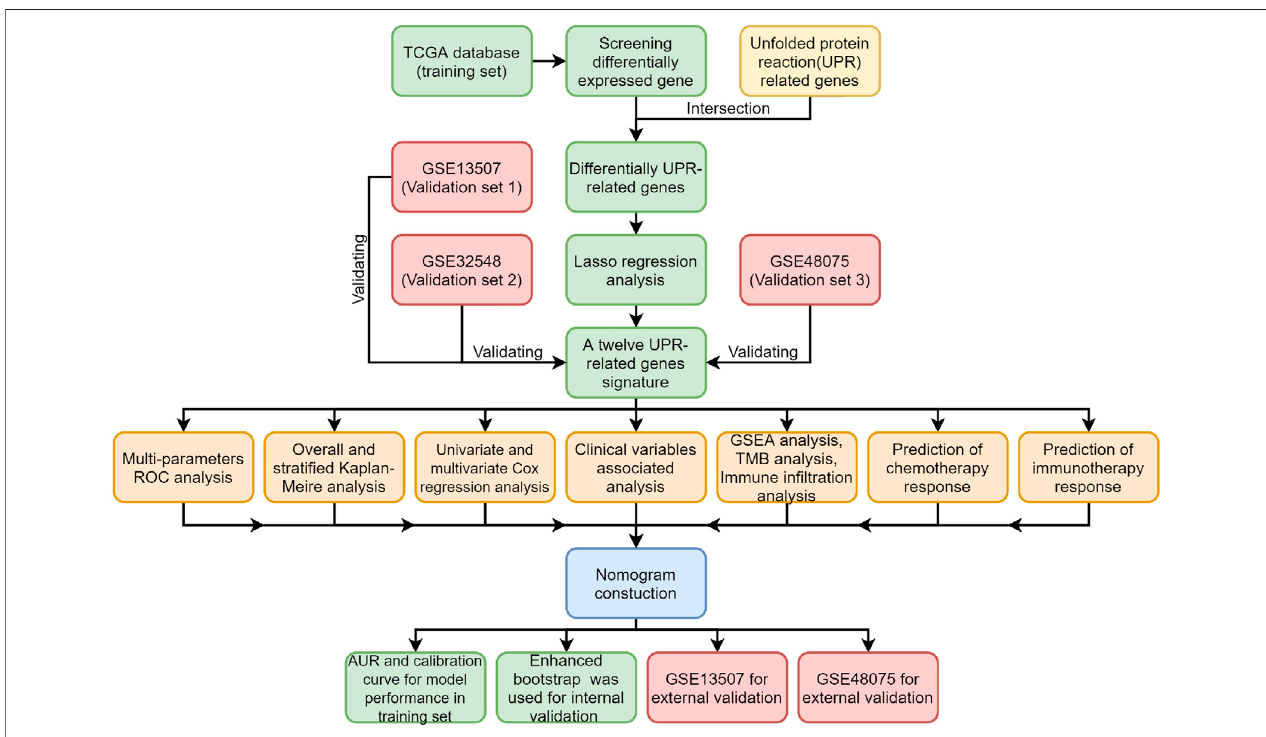
FIGURE 1 | The fl owchart of the